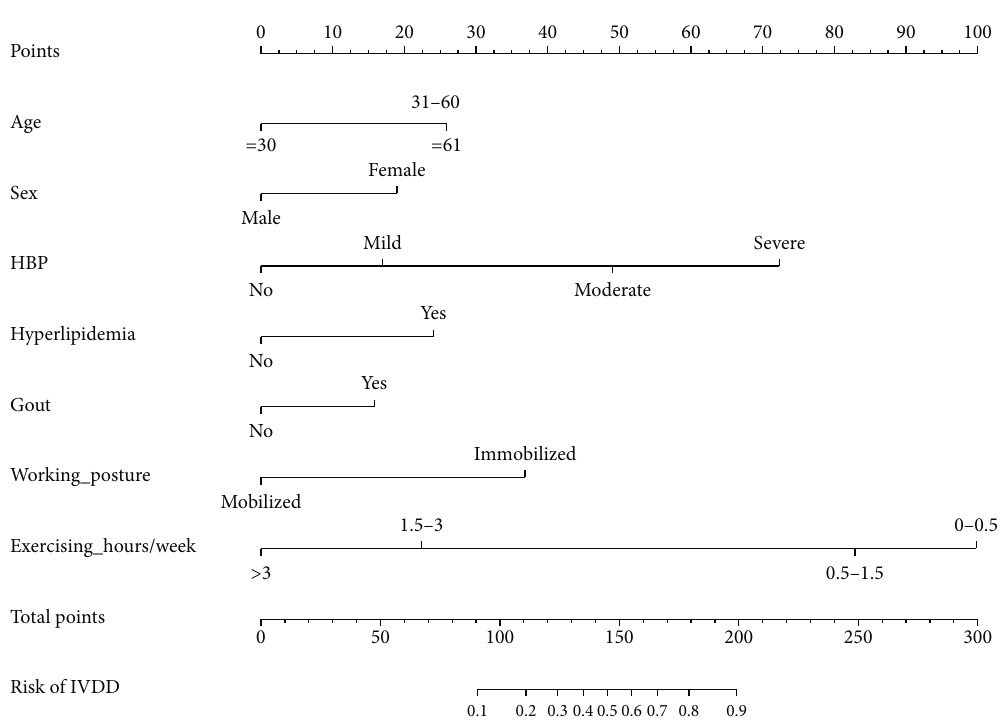
Figure 3: The IVDD nomogram. The predicting nomogram was developed with factors including age, sex, hypertension, diabetes, gout, working posture, and exercising hours per